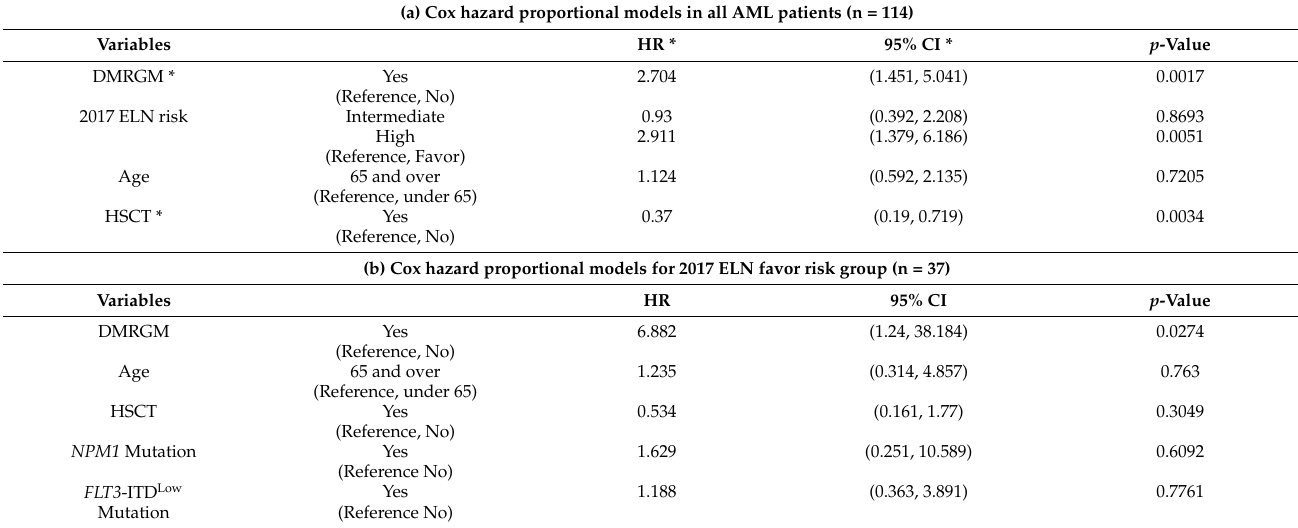
Figure 1. Overall survival (OS) rates by DNA methylation mutation. Red Line: DNA methylation regulatory gene (DMRGM) mutation positive. Blue Line: DMRGM negative. ( A ) OS rate for all AML cases by DMRGM positive versus negative (medial OS: 12 months vs. 33 months, p = 0.0053). ( B ) OS rate for 2017 ELN favorable group by DMRGM positive versus negative (median OS: 7 months vs. not reached, p = 0.0001). ( C ) OS rate for 2017 ELN intermediate group by DMRGM positive versus negative ( p = 0.1172). ( D ) OS rate for 2017 ELN adverse group by DMRGM positive versus negative ( p = 0.7773). Table 3. Multivariate analysis of prognostic factors for overall survival. (a) Cox hazard proportional models in all AML patients (n =